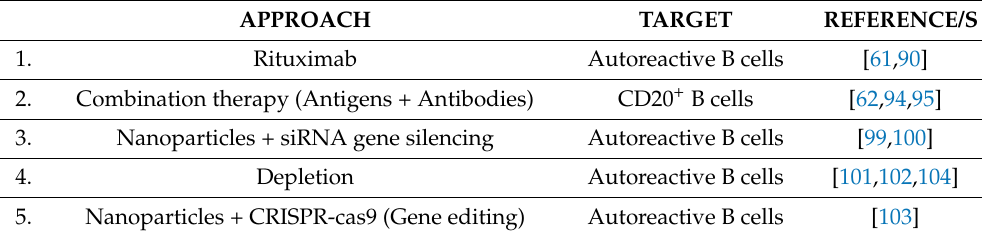
Table 2. Summary of strategies for targeting and regulating B cell population and function to- wards